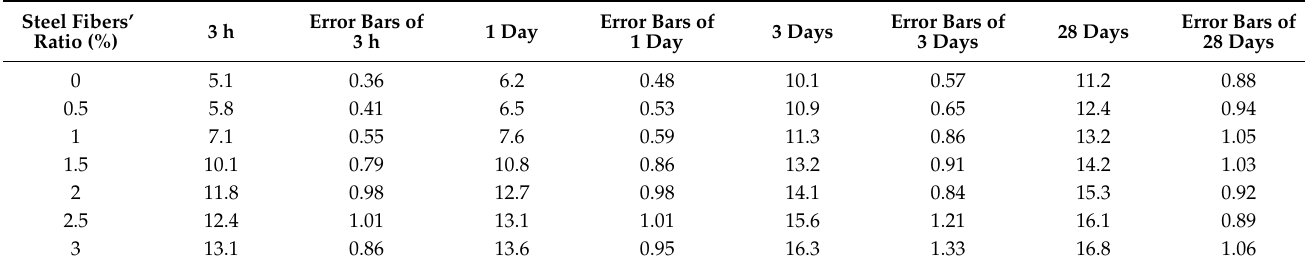
Table A2. The flexural strength strengths of MPC-RPC (MPa).